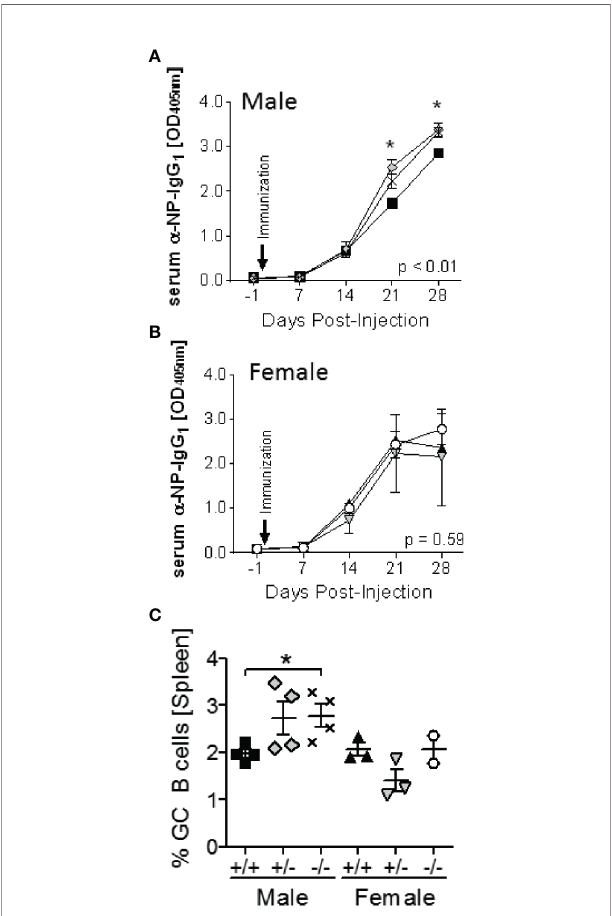
FIGURE 2 | Enhanced response to T-dependent Ag immunization in male S100a9 -/- NZBWF1 mice. Male (A) S100a9 +/+ (black squares), S100a9 +/- (grey diamonds), S100a9 -/- (symbol X), and female (B) S100a9 +/+ (black triangles, up), S100a9 +/- (grey triangles, down), S100a9 -/- (open circles) NZBWF1 mice ( n = 3-4) were immunized on day 0 with NP 27 -CGG in CFA. Levels of NP-speci fi c IgG1 antibodies were determined on days -1, 7, 14, 21 and 28. *p < 0.05, two-way ANOVA. (C) GC B cells were identi fi ed by fl ow cytometry four weeks post immunization. *p < 0.05, Student ’ s unpaired t test with Welch ’ s correction. One-way ANOVA: p <